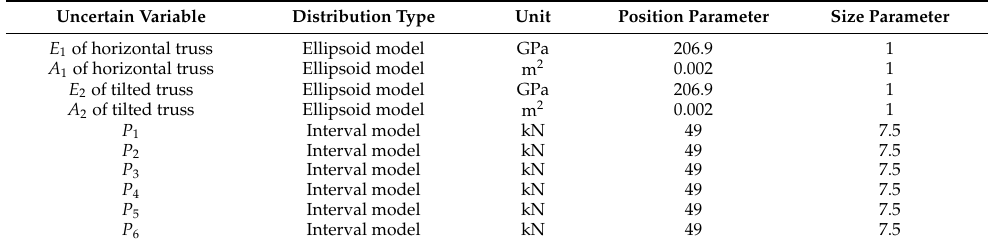
Figure 10. Twenty-three-truss girder. Table 7. Statistical parameters for Example 4.